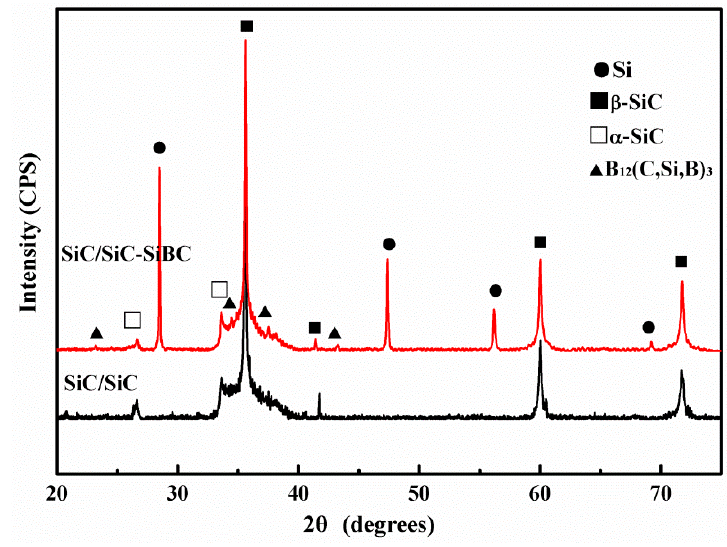
Figure 2. X-ray diffraction (XRD) patterns of SiC/SiC and SiC/SiC-SiBC.